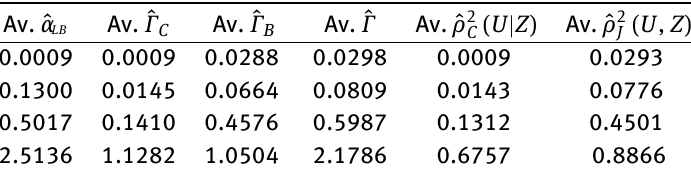
Table 6: Av. estimated information gain and dependence measure given simulated length-biased data, using parametric copula method, for N = 5000, n = m = 1000, r = 0.6 and p = 2